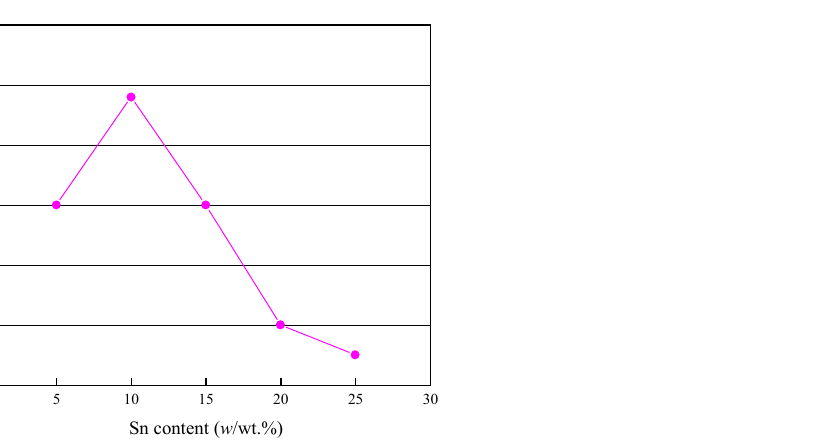
Figure 9. Shear strengths of Cu/Cu joints brazed by using Ag60Cu filler metals with different contents of Sn [15].